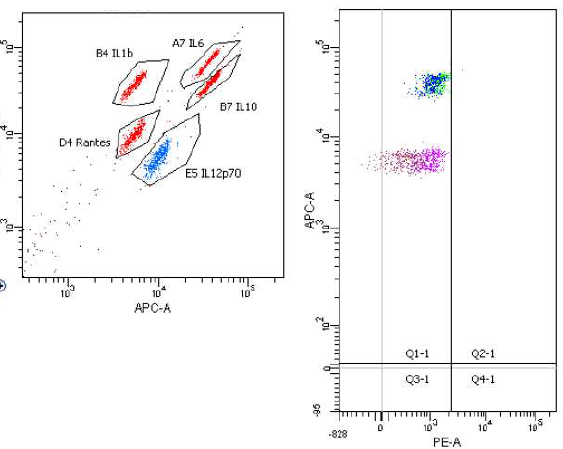
Figure 7. Il-1 β , Il-6, Il-12, Il-10 and RANTES expression in cell suspension with mitogen (Flow Figure 7. Il-1β, Il-6, Il-12, Il-10 and RANTES expression in cell suspension with mitogen (Flow Cy- Figure 7. Il-1β, Il-6, Il-12, Il-10 and RANTES expression in cell suspension with mitogen (Flow Cy- tometry raw data for a single patient). Cytometry raw data for a single patient). tometry raw data for a single patient). Figure 7. Il-1β, Il-6, Il-12, Il-10 and RANTES expression in cell suspension with mitogen (Flow Cy- tometry raw data for a single patient).